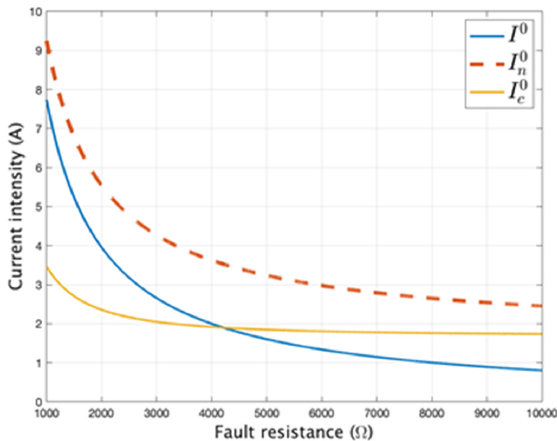
Figure 13. Current 𝐼 (cid:2868) ,𝐼 (cid:3041)(cid:2868) ,𝐼 (cid:3030)(cid:2868) as functions of fault resistance 𝑅 (cid:3047) ∈ [1000, 10,000 Ω ], tan δ = 0.105 ( δ = 6°) 𝑈 (cid:3032)(cid:2868) = 575𝑉 .